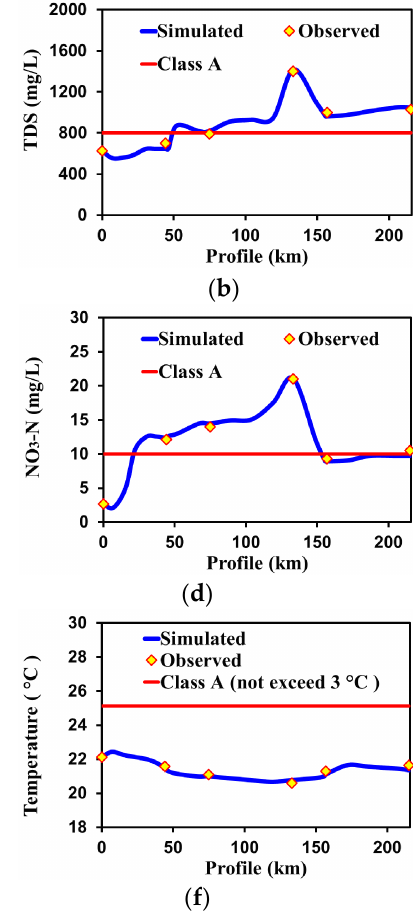
Figure 5. Model calibration of water qualities along the Ravi River for data on 17–18 April 2018: ( a ) BOD, ( b ) TDS, ( c ) DO, ( d ) NO 3 ‐ N, ( e ) NH 3 ‐ N, and ( f ) temperature.